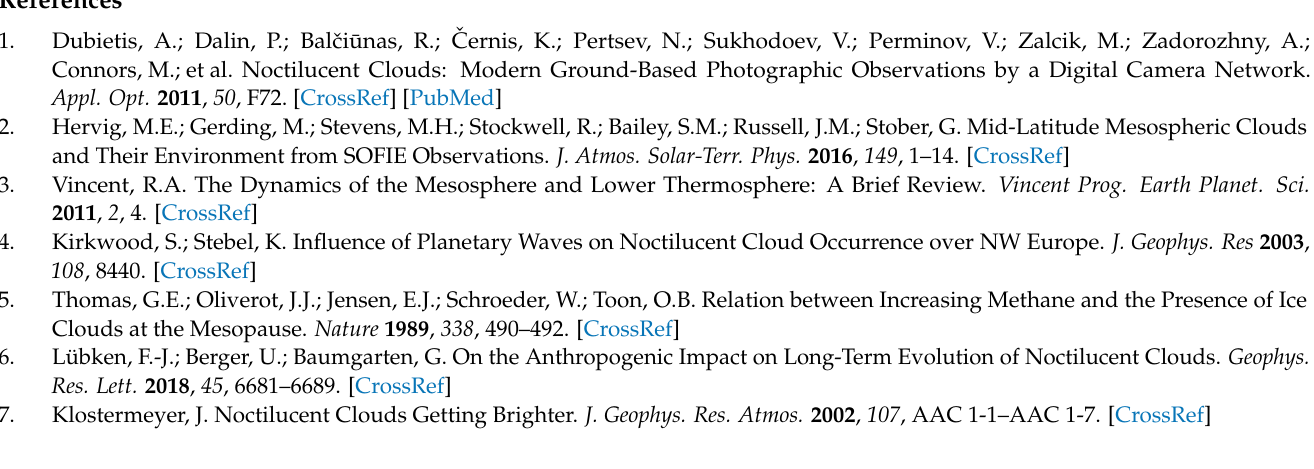
Figure A2. Randomly selected images of NLC category from new locations that are used only for testing, but not used for training/fine-tuning the classifier models.